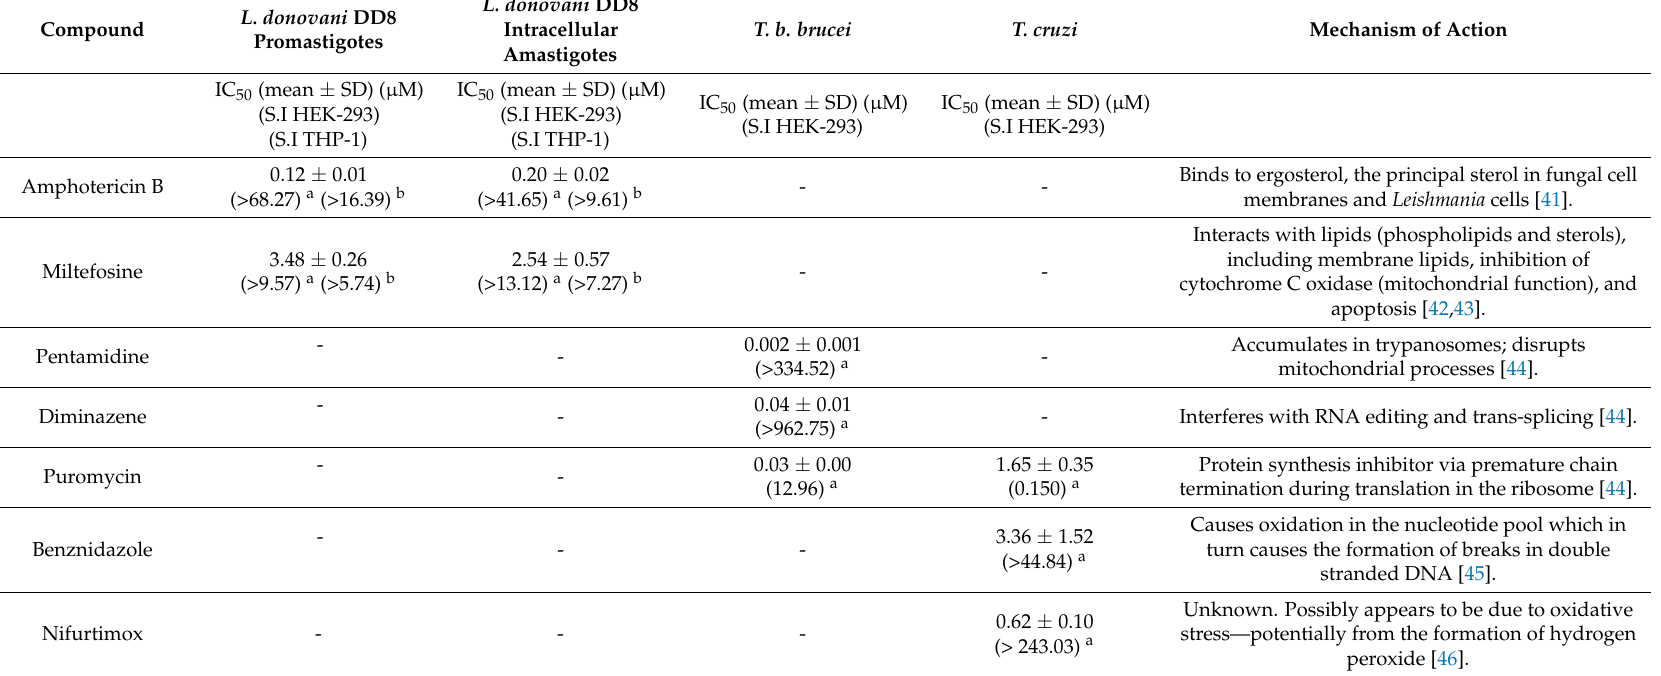
Table 1. Dose response and mechanism of action of reference compounds against L. donovani DD8 , T. b. brucei and T. cruzi